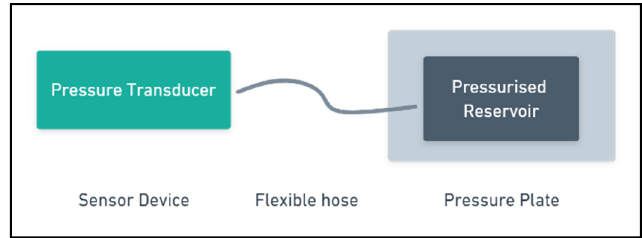
Figure 6. Block diagram of ‘Pressure Slab’ Components.